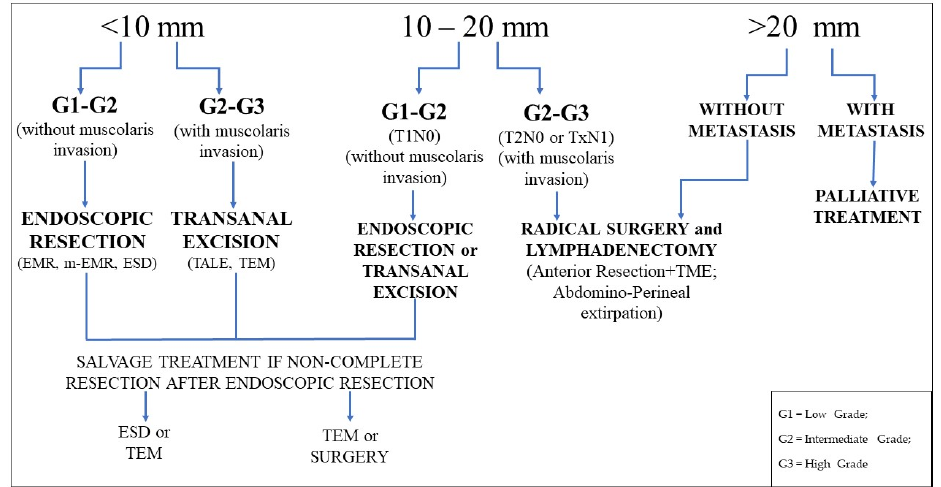
Scheme 2. Proposed algorithm of treatment of Rectal NETs based on tumor size, grading and presence or not of